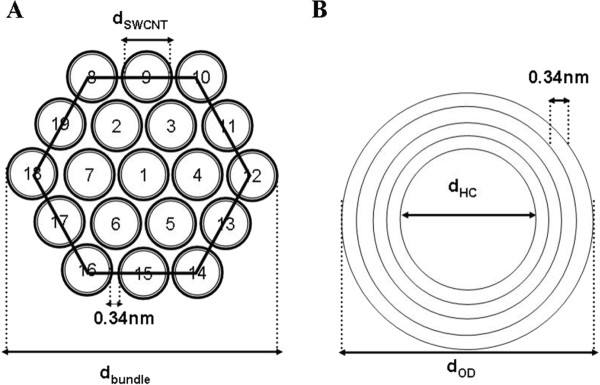
Schematic representation of the SWCNT bundles and CNF. (A) A hexagonal arrangement model of a bundle containing two layers of SWCNT. The labels dSWCNT and dbundle correspond to the diameters of SWCNT and a bundle of SWCNT, respectively. (B) A model of CNF showing five carbon layers. The labels dOD, and dHC correspond to the outer and hollow core diameters of CNF, respectively.